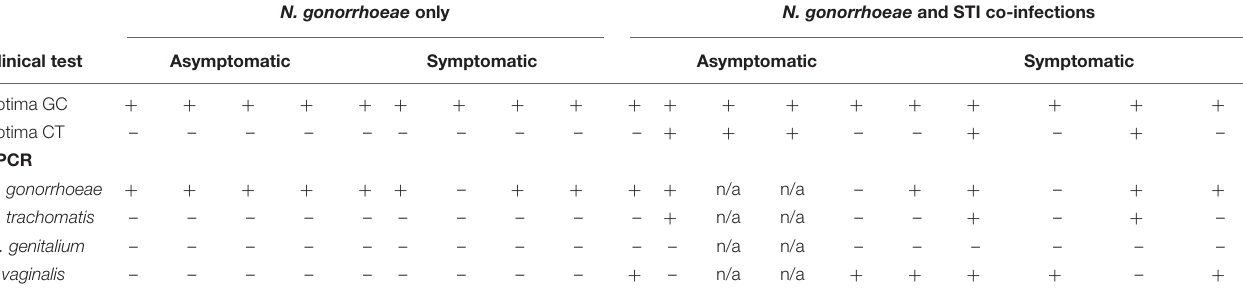
TABLE 2 | Results of clinical Aptima (NAAT) test results and microbial DNA real-time PCR (qPCR) array.